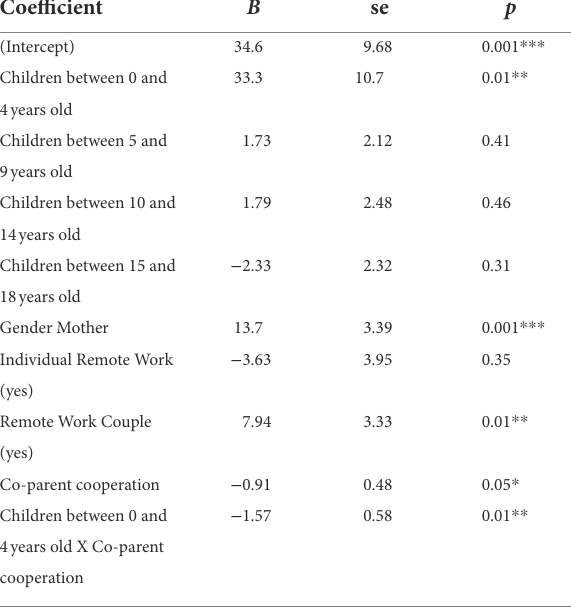
TABLE 4 Objective regression model 2, without multiple